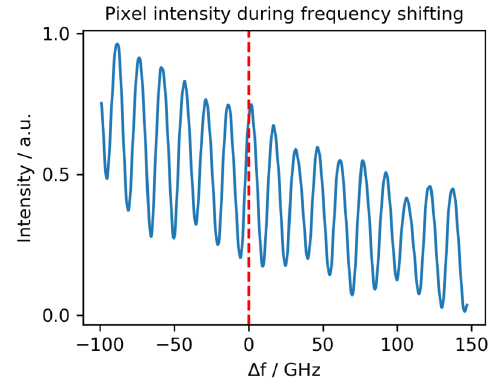
Figure 2. Wavelength shifting interferometry: Measured inten- sity of a specific pixel in dependence on the frequency shift ∆ f of the laser diode, relative to the centre wavelength of 633 nm. The carrier frequency corresponds to the cavity length.